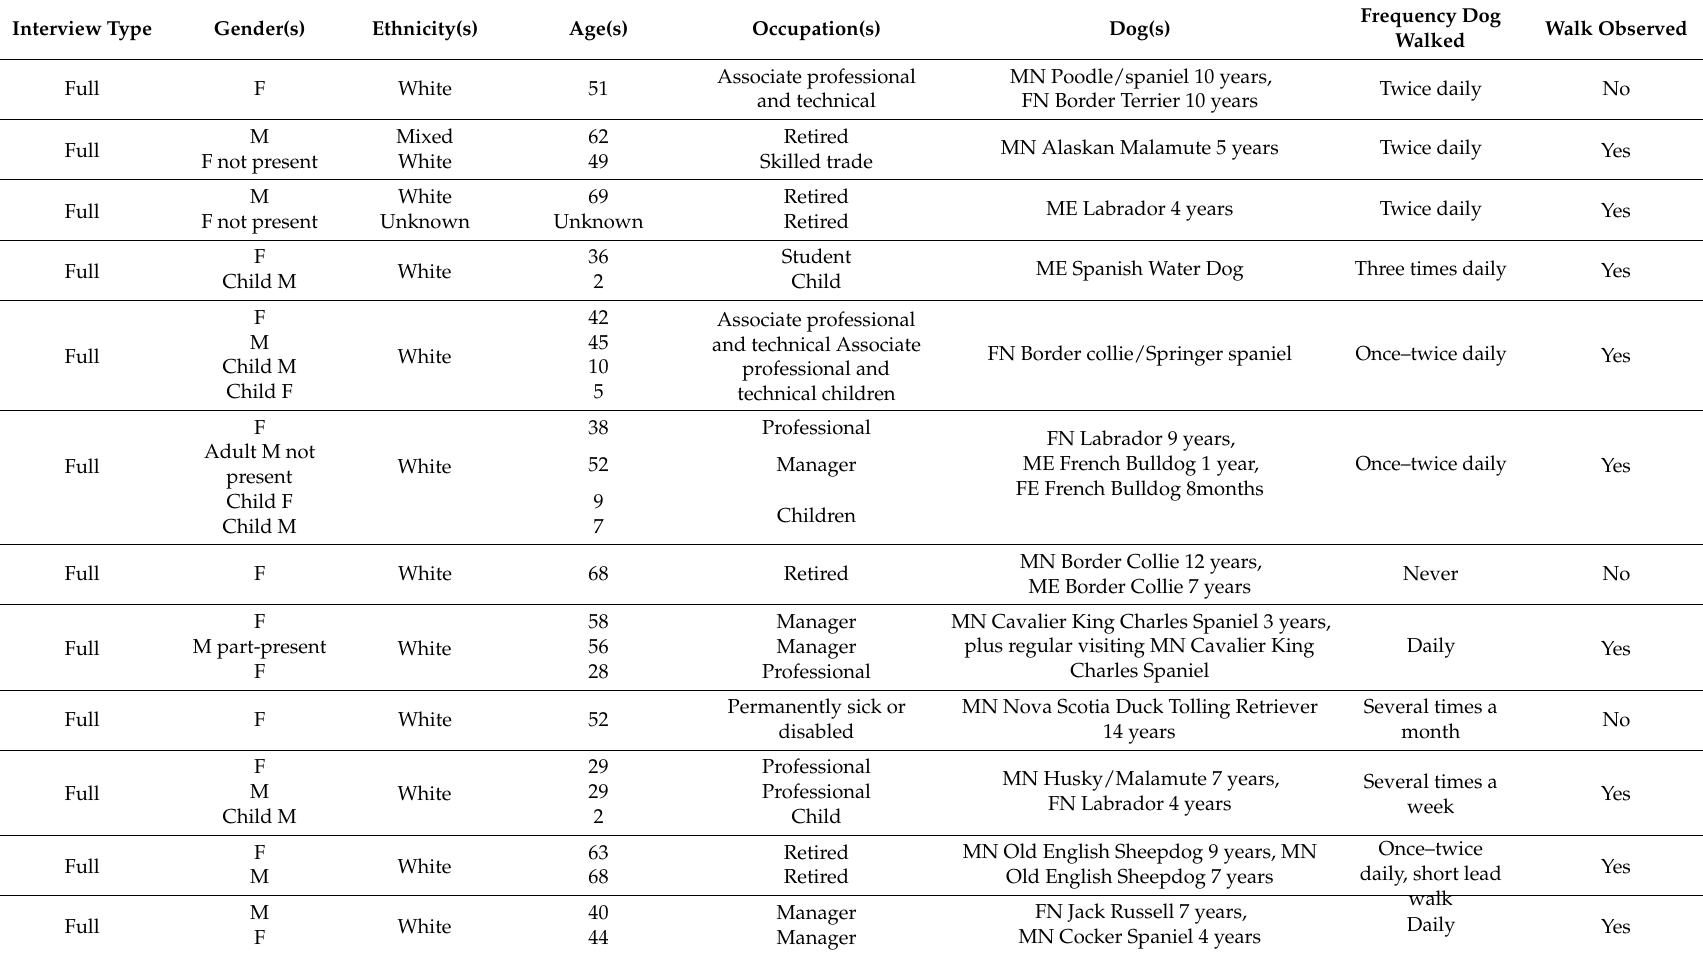
Table 1. Participant information of dog owner interviews about dog